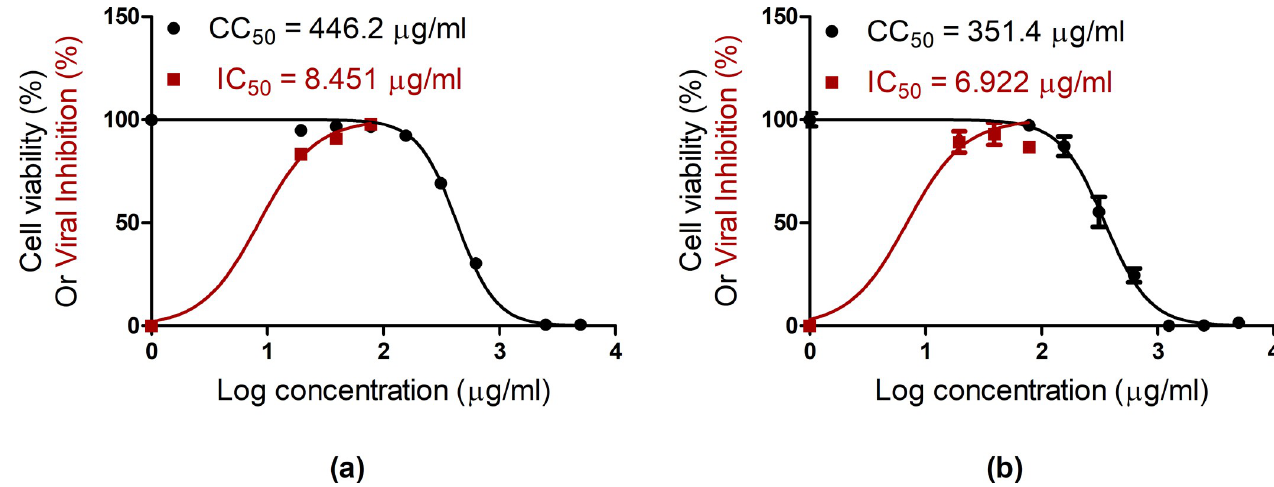
Fig 2. Cytotoxicty and anti-SARS-CoV-2 activities for A . indica L. (Neem) leaves extract (a) and M . azedarach L. leaves extract (b). CC 50 : half-maximal cytotoxic concentration; IC 50 : half-maximal inhibitory concentration; IS: selectivity